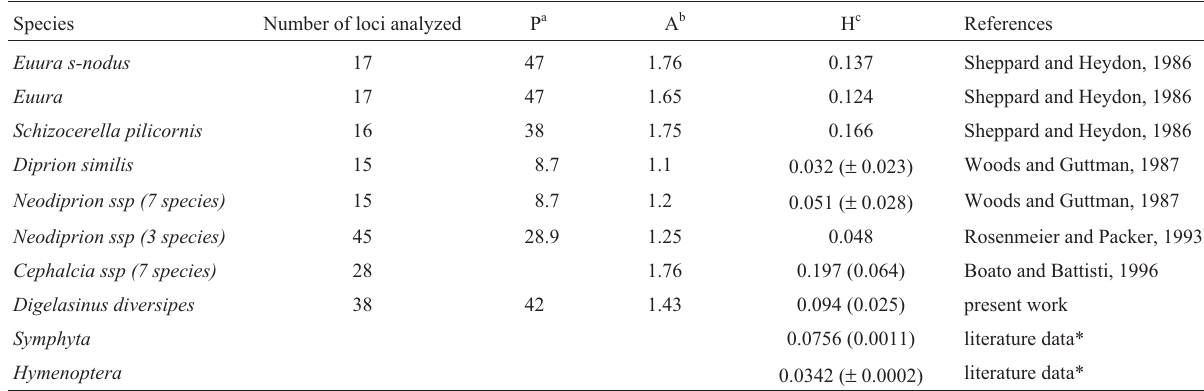
Table 4 - Genetic data used in the analyses of this work. Species Number of loci analyzed P